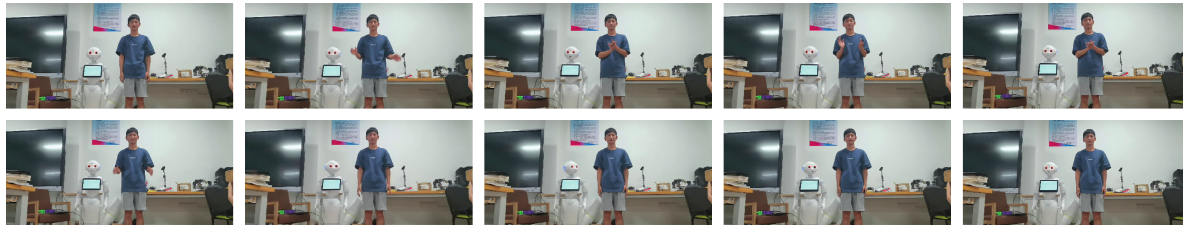
Figure 8: Action interaction with applause as an